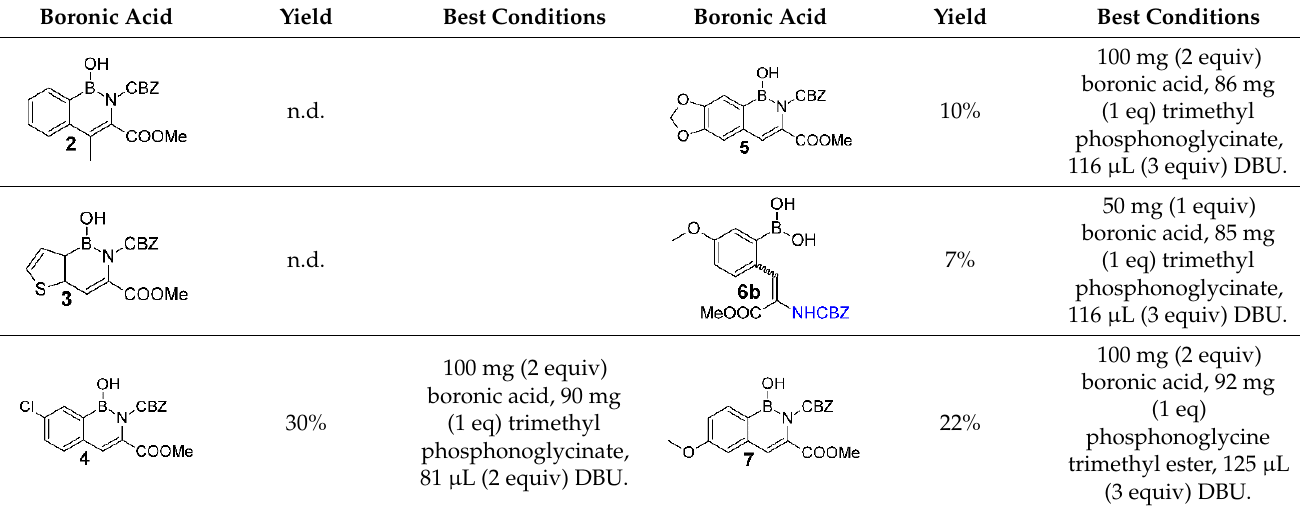
Table 2. Results of syntheses with different boronic acids.